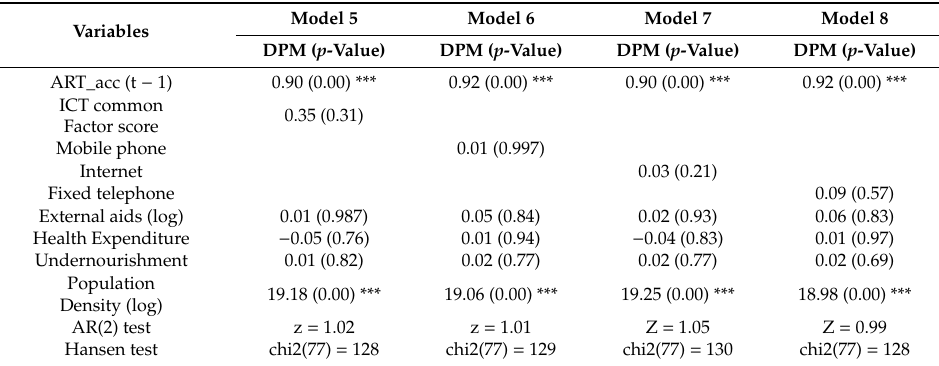
Table 3. Estimation results: ICT and access to antiretroviral medications.